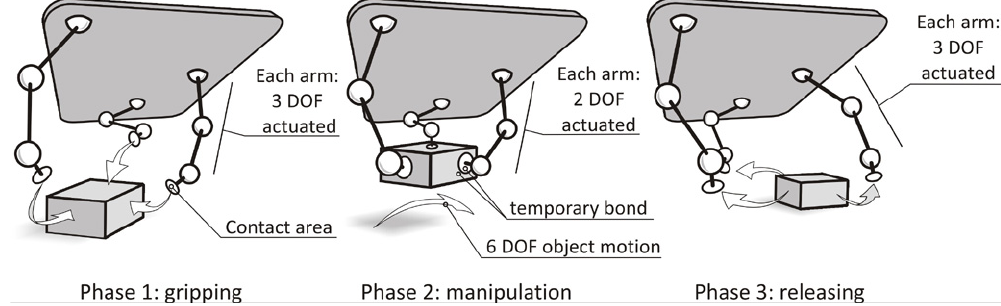
Figure 3. Movement sequence when handling an object.